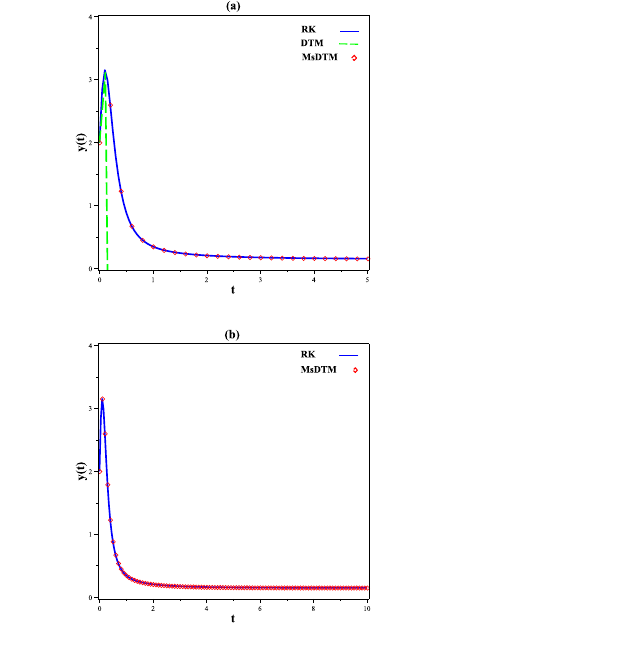
Figure 6: The density of the humans infected with avian influenza with r 0 = 1.06 and R 0 ≈ 3.5